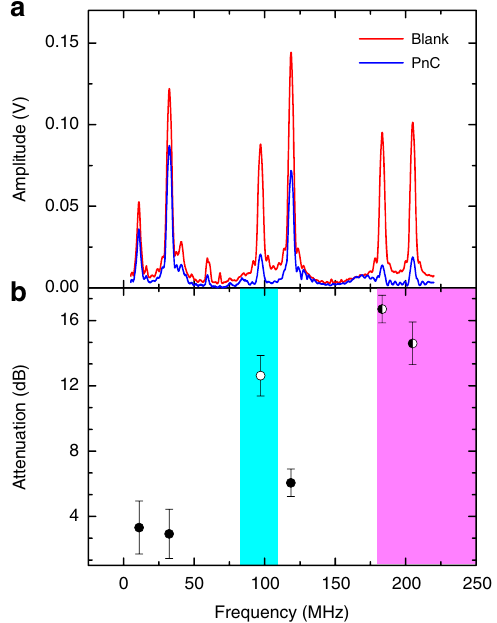
Fig. 4 Experimental SAW transmission through PnC. a Transmission spectra of SAWs excited and detected through inter-digital transducers (IDTs) for a device with an unpatterned, blank substrate and with a 3 mm × 80 µ m square array of fi nite depth annular holes as a PnC. b SAW attenuation of propagating SAWs at each resonant IDT peak relative between a blank substrate and the fabricated PnC, calculated as 20 log ð A patterned = A blank Þ , with s.d. error bars. Solid on white , empty on blue and half- fi lled on pink markers represent frequencies of expected propagating SAW bands, bandgap and leaky SAWs